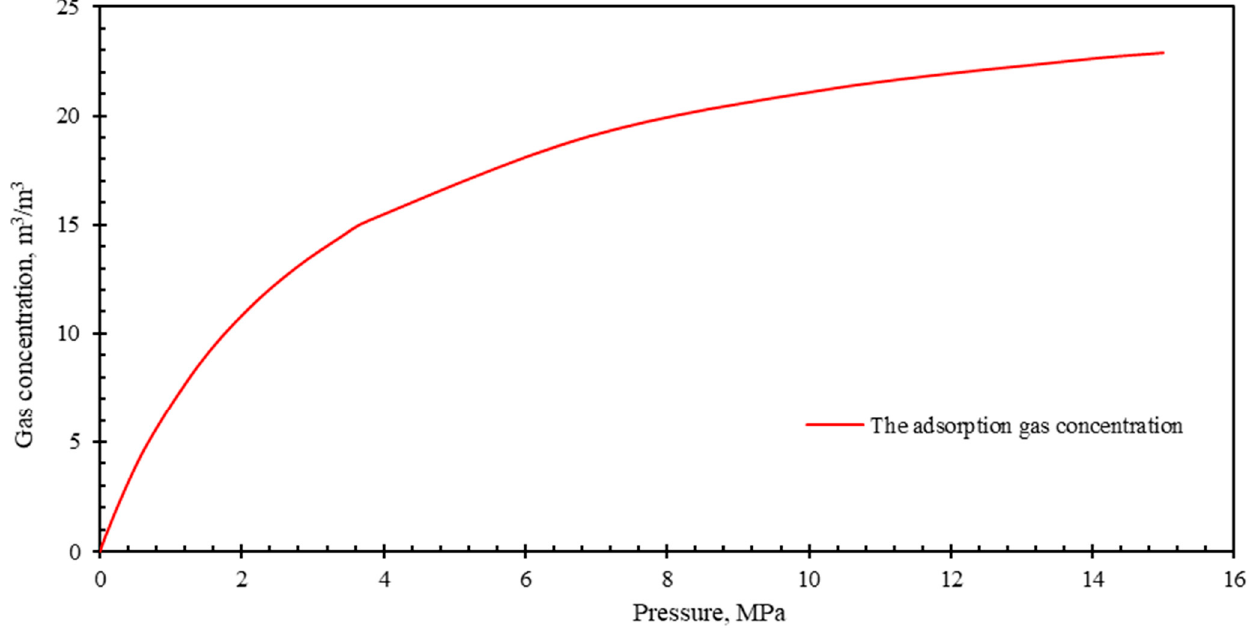
Figure 3. Adsorption gas concentration used in the numerical simulation model.